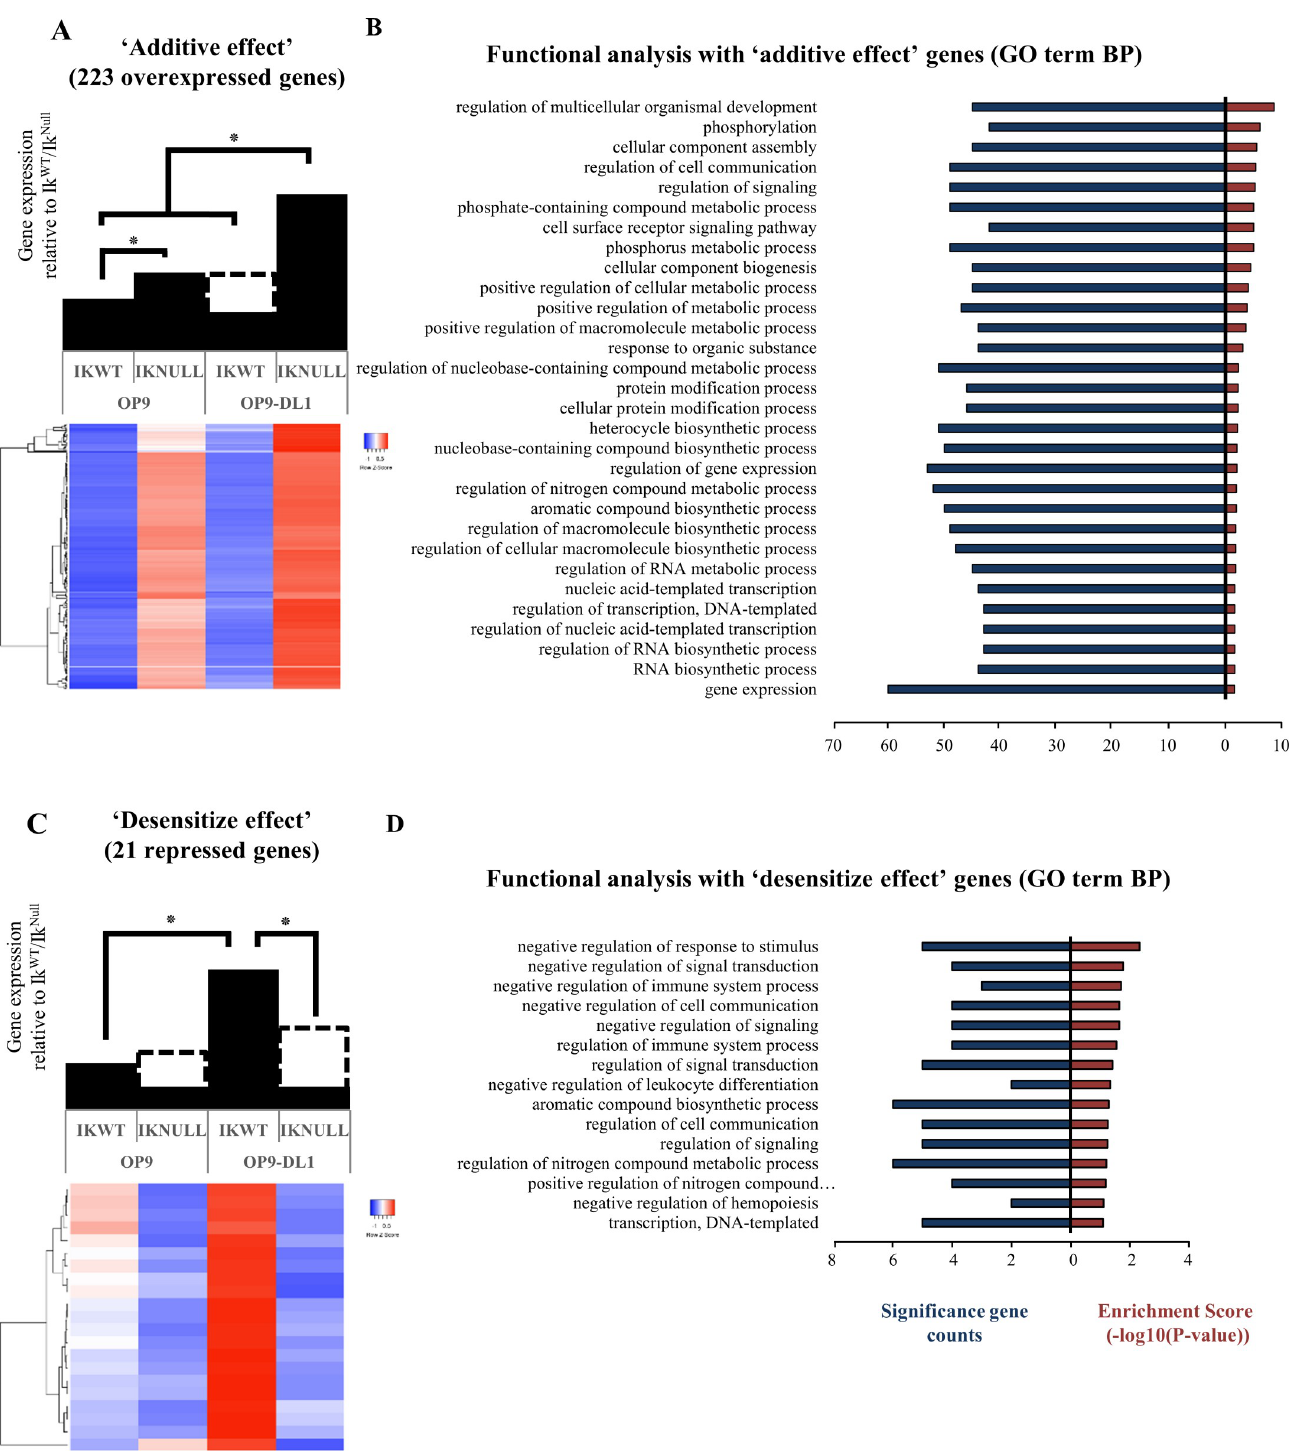
Fig 2. IKAROS deletion promotes deregulation of several genes related to different cellular functions upon NOTCH induction. (A, C) Model bar graphs and heatmaps depicting the expression pattern of 223 overexpressed (panel A) or 21 repressed (panel C) genes upon IKAROS ablation and NOTCH induction (Ik Null vs Ik WT on OP9 cells relative to Ik Null vs Ik WT on OP9-DL1 cells). Colors on the heatmaps (depicted in the color key) represent the relative expression levels of individual genes in the four conditions used for this study (as indicated above the heatmaps); unsupervised hierarchical clustering (Pearson correlation, average linkage) over the genes included in each group, is depicted on the left side of the heatmaps. (B, D) DAVID functional annotation clustering analyses of genes